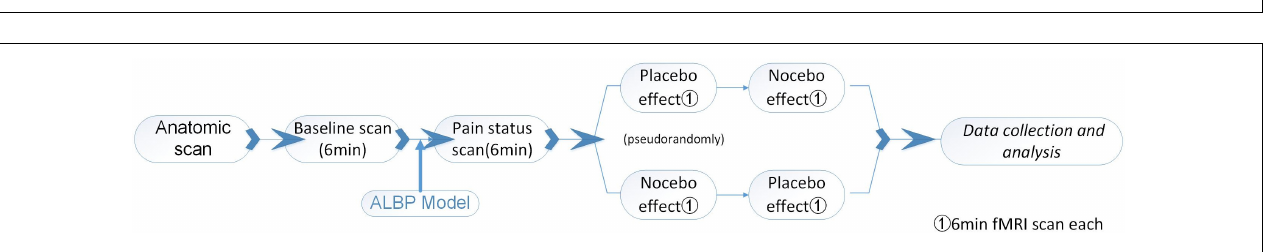
FIGURE 1 | ALBP model location.